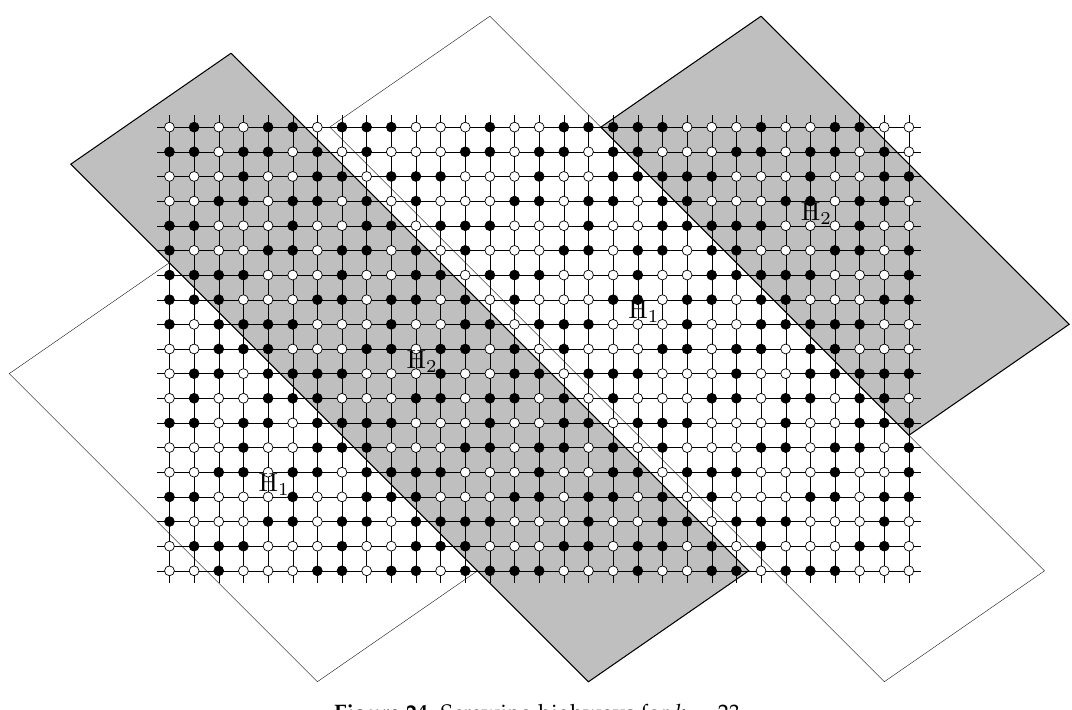
Figure 24. Screwing highways for h =